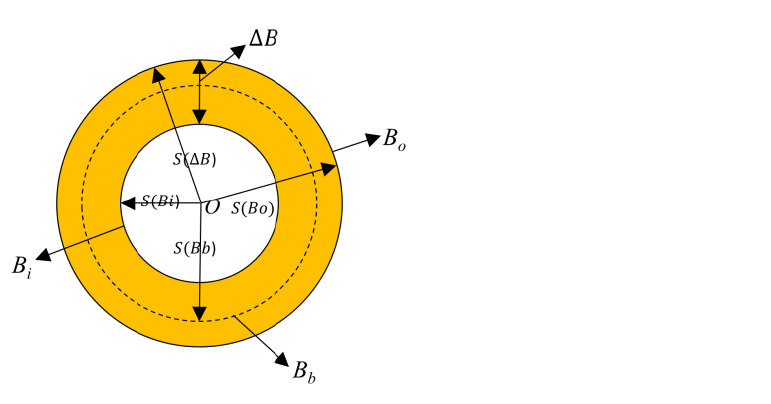
Figure 2. Relationship of the structuring elements in NWTH [23]. ∆ B consists of B i and B o , ∆ B and represent structural elements for dilation and erosion operations, respectively.